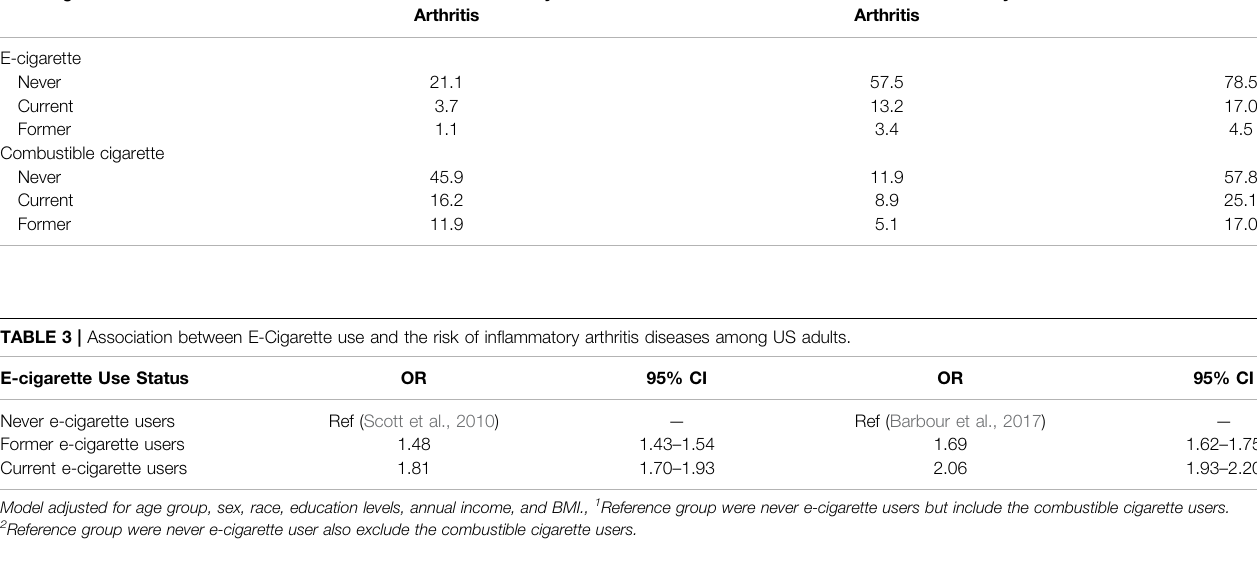
TABLE 2 | Prevalence of smoking rate of e-cigarette and combustible cigarette usage among BRFSS participants (%). Smoking Status